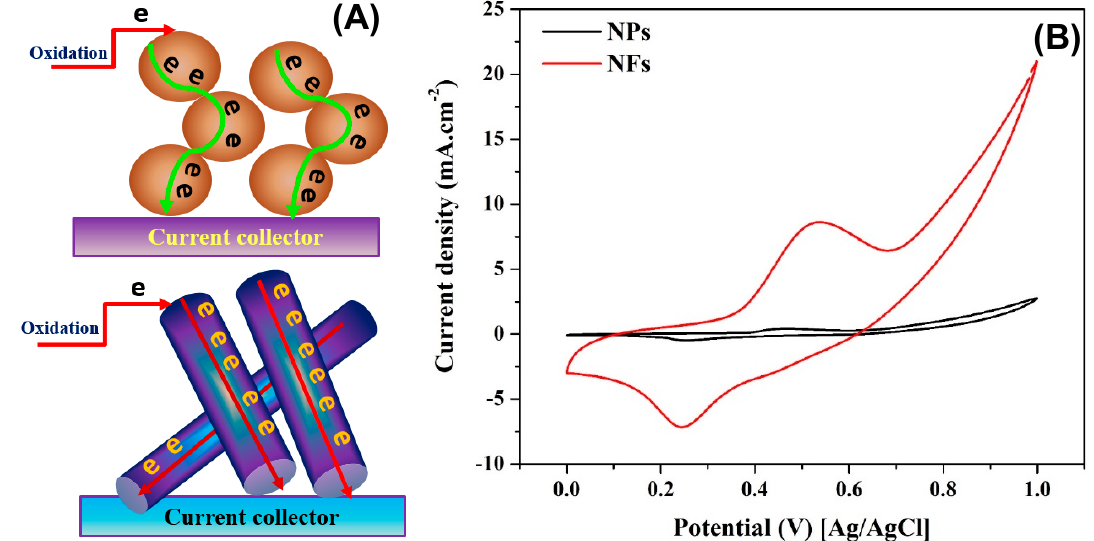
Figure 8. Schematic illustration of the electron passing through the nanoparticles and nanofibers ( A ). Influence of the nanostructural morphology on the ESA of the activated composites containing 10 wt % Sn and calcined at 850 °C ( B ).